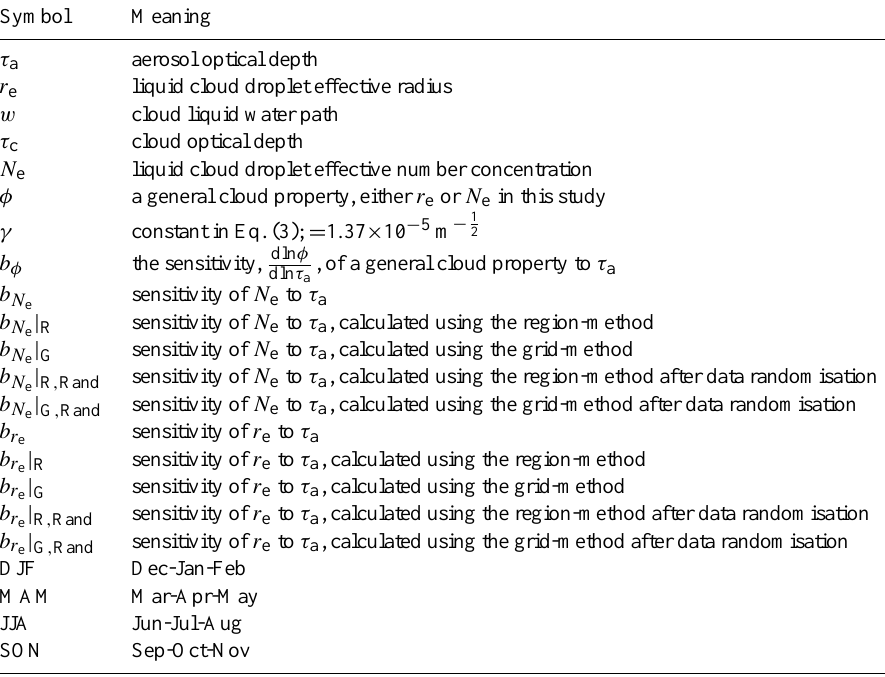
Table 1. A summary of the notation used in this paper.